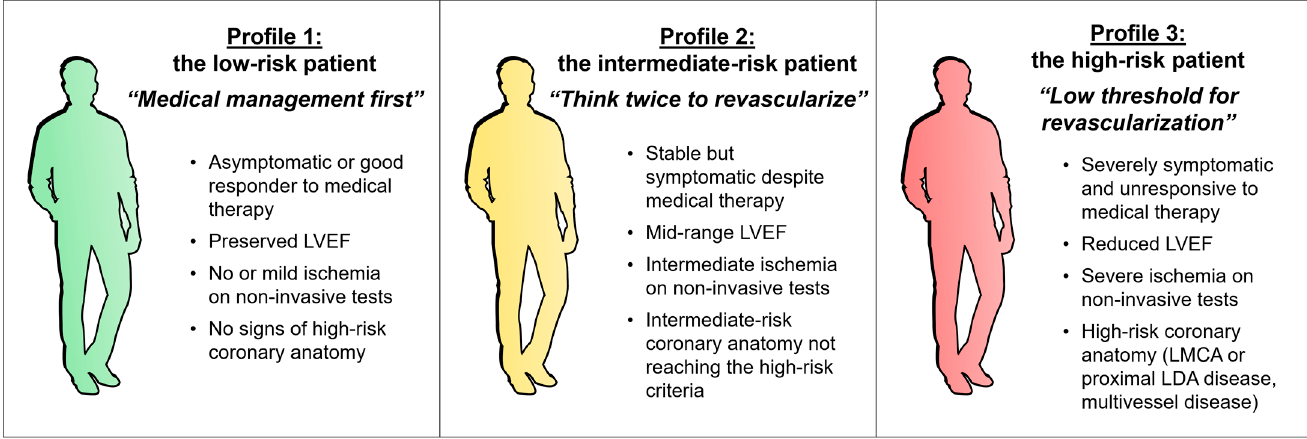
Figure 4. Patient profiles in chronic coronary syndrome to guide a revascularization strategy. Based on symptoms, LVEF, and the anatomical and/or physiological repercussion of coronary lesions, three patient profiles can be established. In patient profiles 1 (“low-risk”, medical management first) and 3 (“high-risk”, low threshold for revascularization), decision-making is relatively easy. In patient profile 2 (“intermediate-risk”, think twice to revascularize), factors depicted in Figure 3 have to be cautiously considered. Abbreviations: CMR, Cardiac magnetic resonance; LAD, Left anterior descending artery; LGE, Late gadolinium enhancement; LMCA, Left main coronary artery; LVEF, Left ventricular ejection fraction; PD, Perfusion